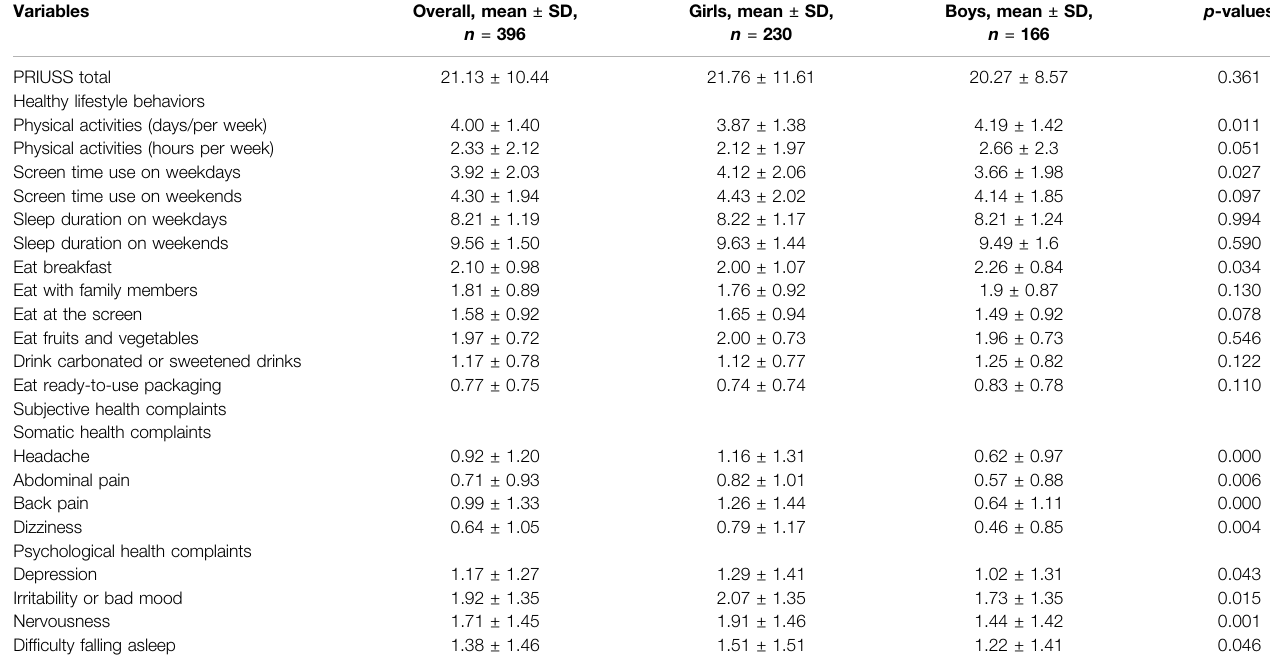
TABLE 1 | Descriptive data of the study participants, by gender. Variables